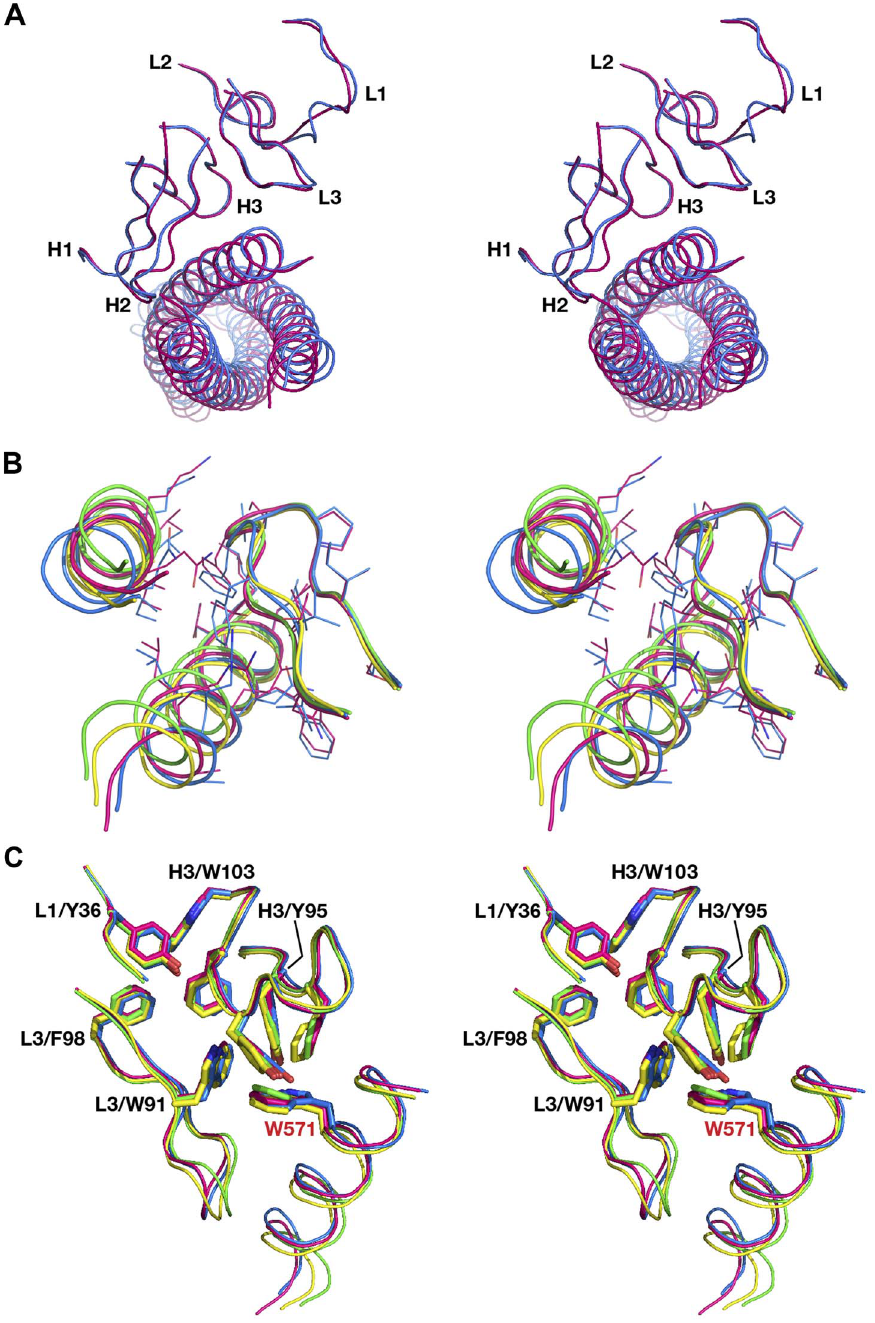
Figure 10. Comparison of the antigen-antibody interactions of single Fabs 8066 and 8062 in the complexes with 3-H and 5-Helix. Fabs were superimposed using the C a traces of the b -sheet framework of the variable domains. CDRs and N-HR helices of the complexes of Fab 8066 with 3-H and 5-Helix are shown in red and green, respectively, while the corresponding fragments of the complexes of Fab 8062 are blue and yellow. (A) Superposition of all CDRs in two complexes with 3-H. (B) Contacts between CDRs H2 and two 2 N-HR helices in the four complexes. (C) A similar conformation of CDR H3 in the four complexes is stabilized by a cluster of aromatic residues from CDRs H3, L1 and L3. Residues F96, Y100B, and F100D of CDR H3 are displayed, but, for clarity, are not labeled.